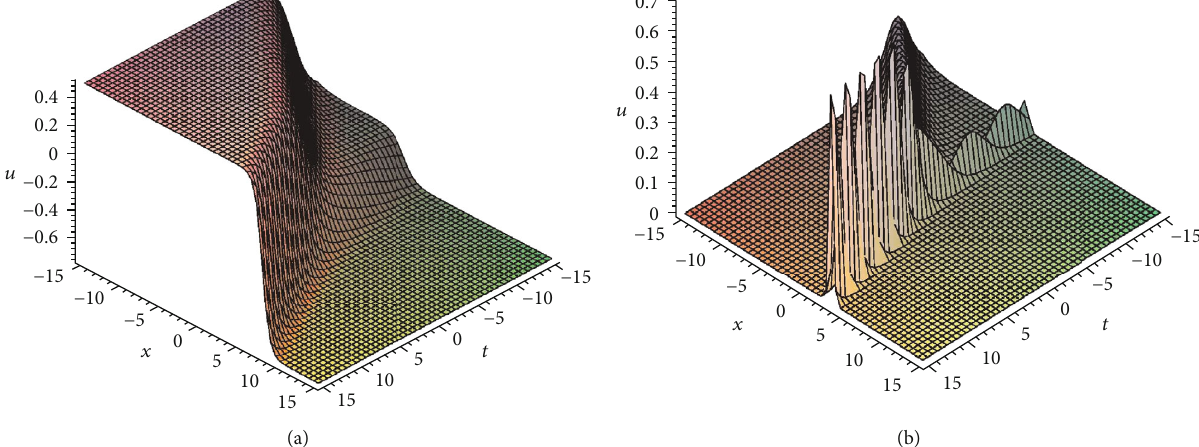
Figure 3: Plot (a) and (b) to the resonant soliton solution of u and v with k < 0 . (a) is the two kink solitary wave fi ssion solution for u , and (b) is the solitary wave fi ssion for v .